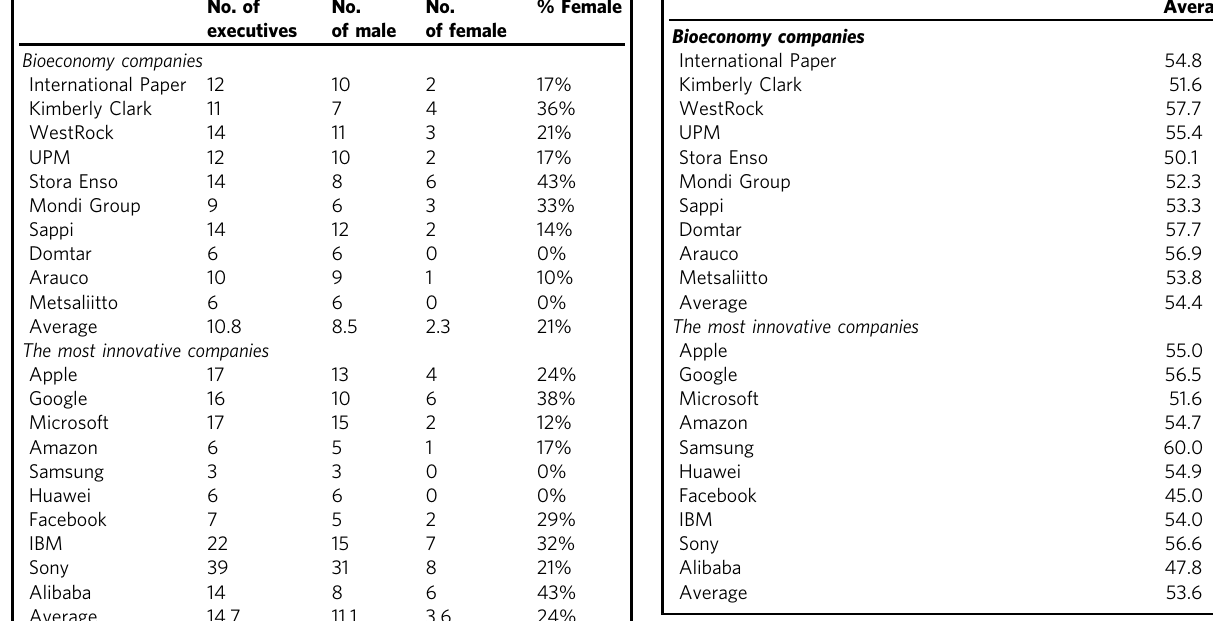
Table 4 Gender diversity in the bioeconomy and the most innovative companies.